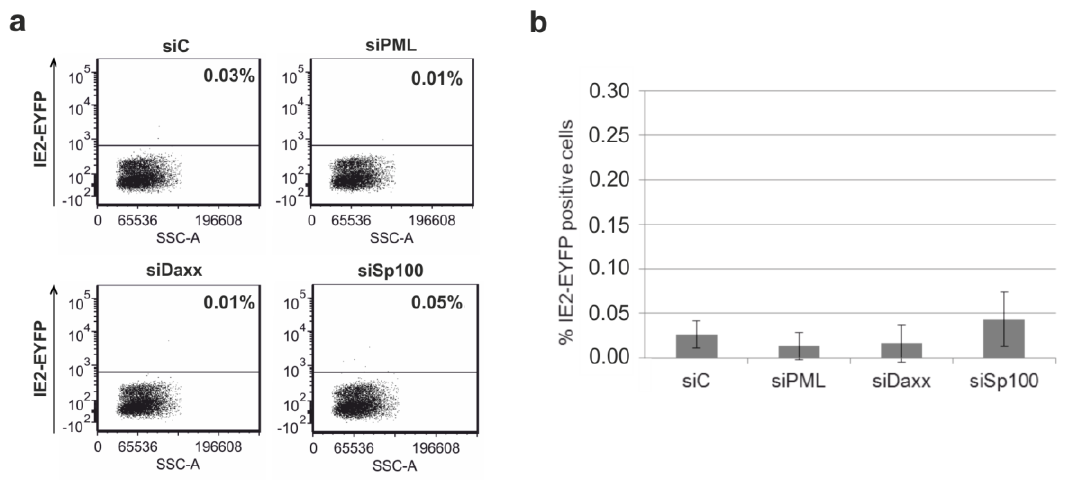
Figure 6. Knockdown of PML, hDaxx or Sp100 in THP-1 monocytes does not permit HCMV IE gene expression. ( a ) Equal numbers of siC, siPML, siDaxx and siSp100 THP-1 cells were infected with TB40E/IE2-EYFP at an MOI of 0.1. EYFP expression was measured at 24 hpi by flow cytometry; ( b ) Mean values of three individual infection experiments according to ( a ). Statistical analyses using the paired t test for siC and siPML, siDaxx and siSp100, respectively, revealed no significant differences between knockdown and control cells siC.